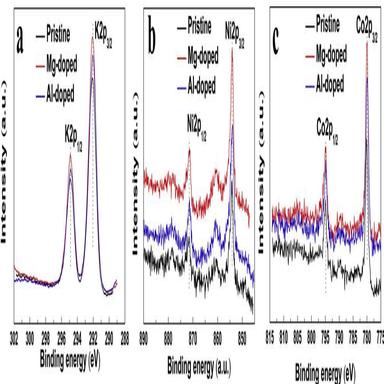
XPS spectrum of (a) K 2p, (b) Ni 2p and (c) Co 2p for the pristine, Mg-doped, and Al-doped samples.